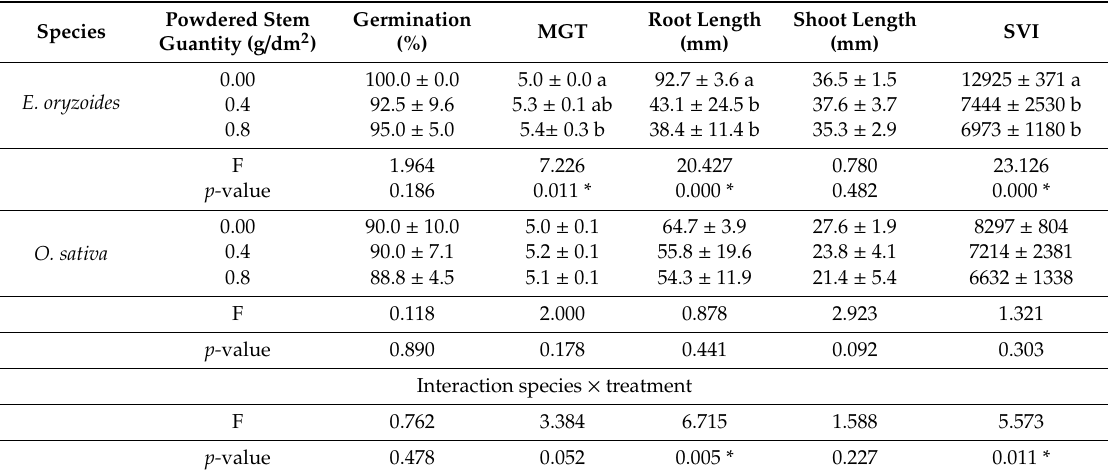
Table 2. Germination indices measured for E. oryzoides and O. sativa under the e ff ect of di ff erent quantity of L. multiflorum powdered